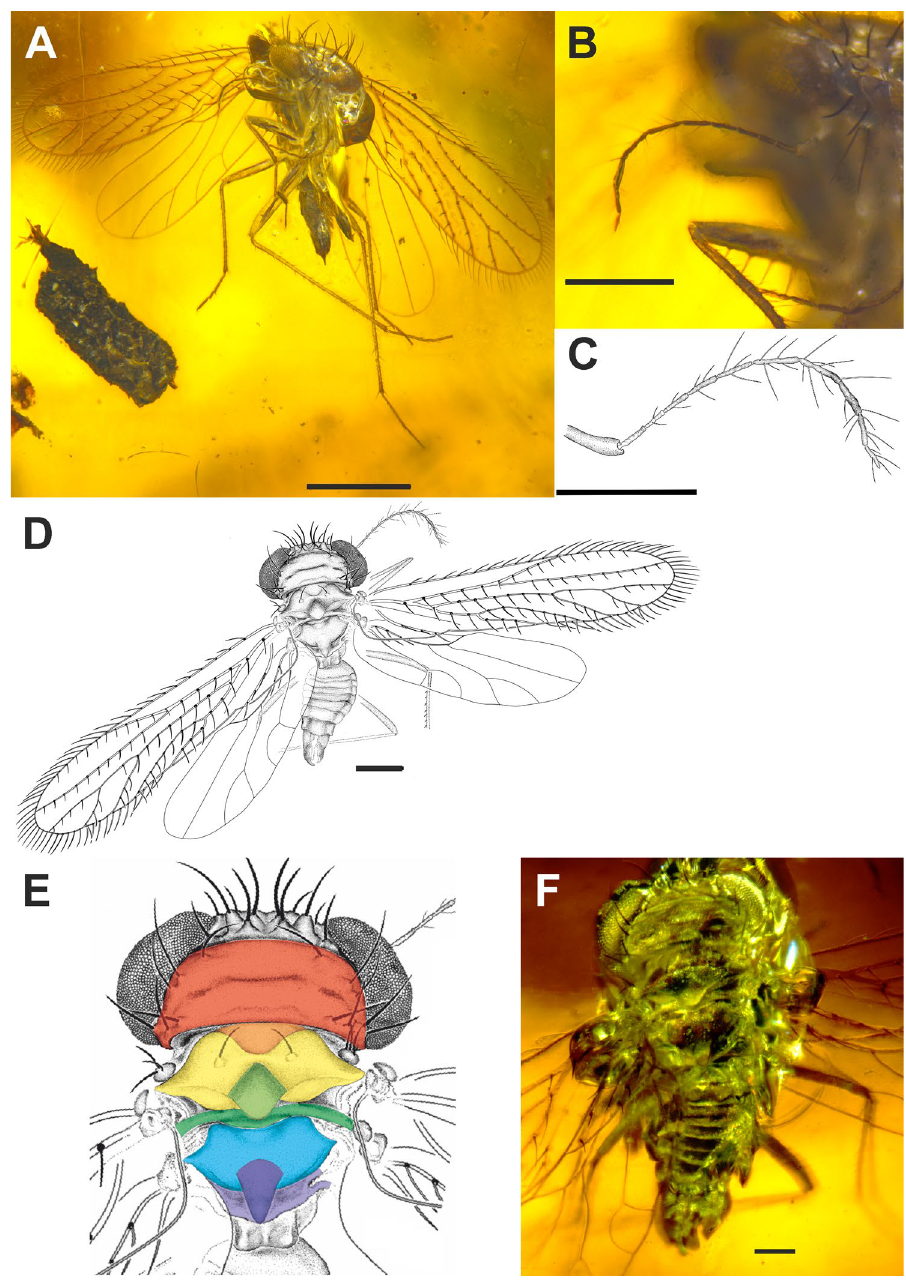
Figure 1. Megalophthallidion burmapteron gen. et sp. nov., holotype (MAIG 6687), imago. ( A ) Photo of body, ventral side; ( B ) photo of right antennae and ( C ) drawing of antenna; ( D ) drawing of body, dorsal side; ( E ) drawing of thorax structure with sclerites marked: red—pronotum; orange—mesopraescutum; yellow— mesoscutum; light green—mesoscutellum, dark green—mesopostnotum; light blue—metascutum; dark blue— metascutellum; violet—metapostnotum; ( F ) photo of thorax dorsal side. Scale bars: 0.5 mm ( A ), 0.2 mm ( B–D ), 0.1 mm ( F